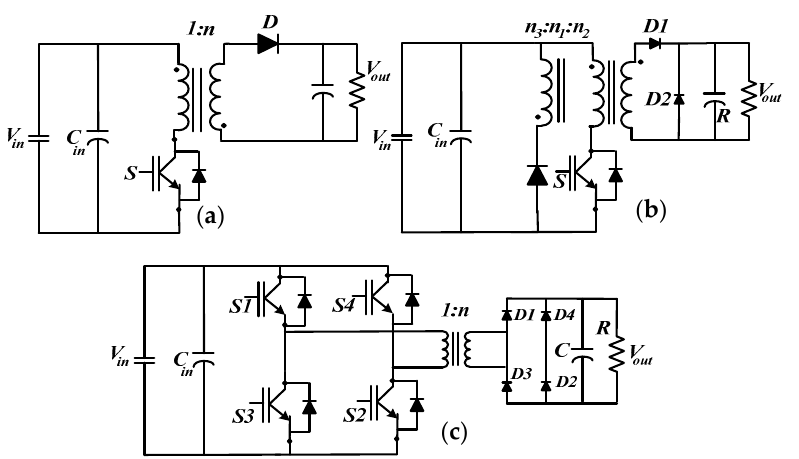
Figure 31. Isolated DC-DC converter: ( a ) flyback converter, ( b ) forward converter, and ( c ) full-bridge converter [134]. Table 3. Comparison of different DC-DC converters topology for energy harvesting. Refs.